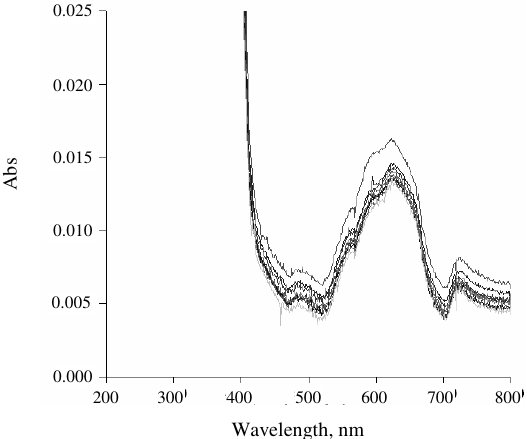
Figure 2. Overlay scan of reaction mixture with respect to time